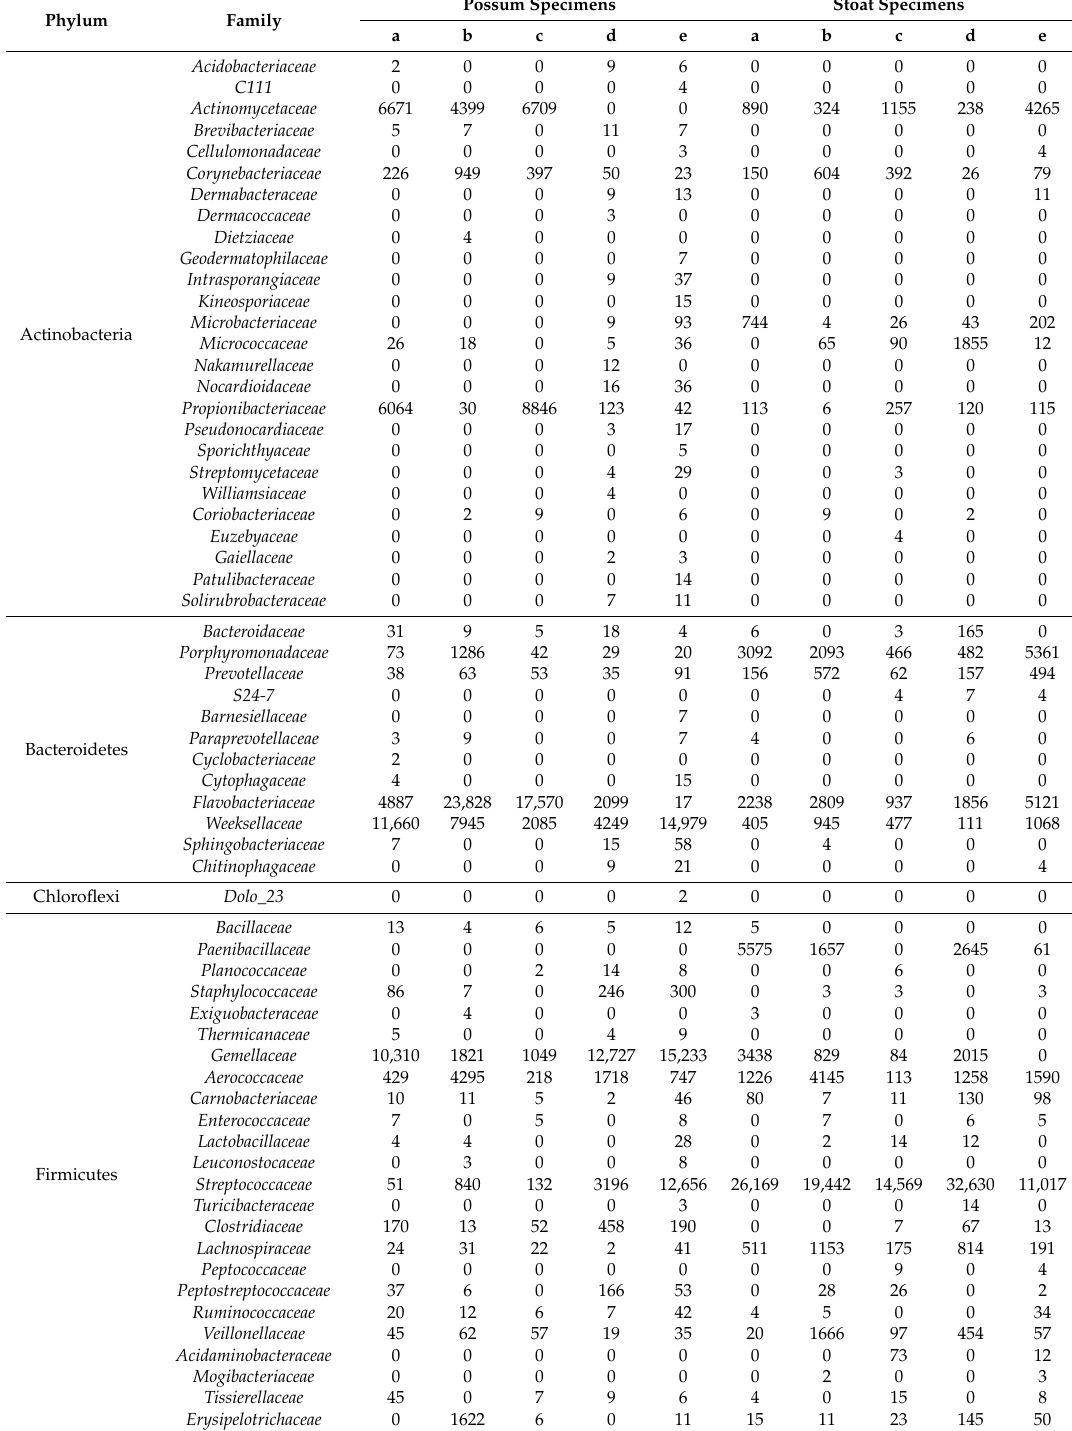
Table 1. Abundance of di ff erent bacterial families identified from the oral microbiota of brushtail possums and